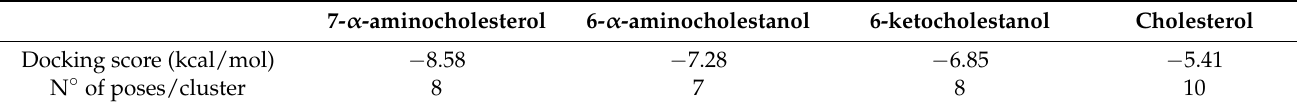
Table 4. Docking scores of docked